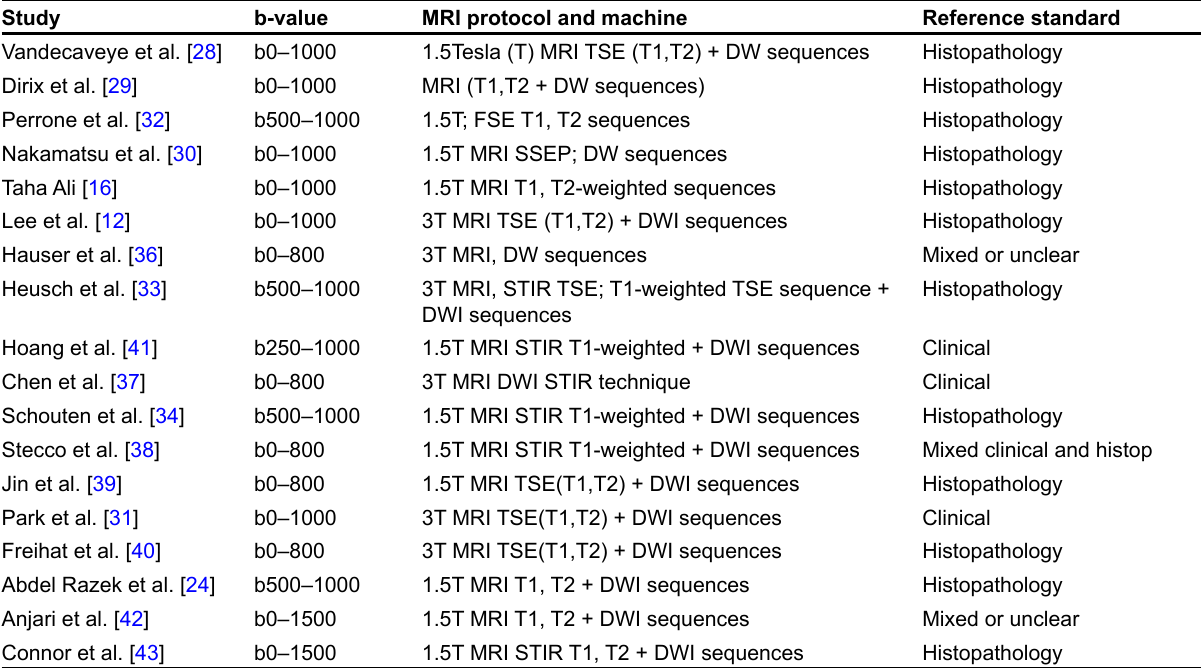
MRI characteristics of the included studies. Among the 18 relevant papers, the b-values used in